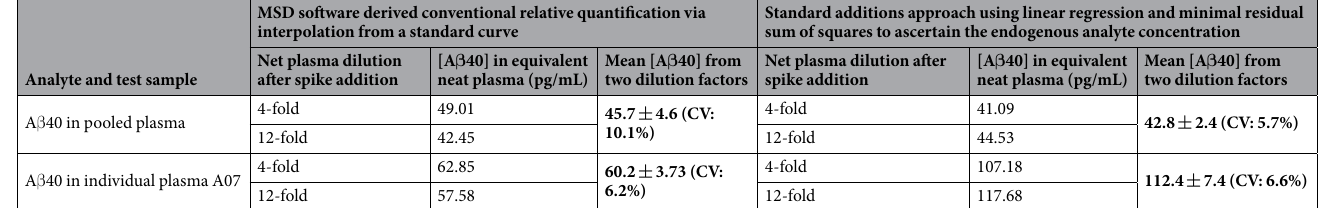
Table 3. Comparison of endogenous A β 40 concentration data derived by conventional relative quantification of the unspiked test samples and the standard addition approach using linear regression to correlate the signal output with the total analyte concentration of spiked test samples. A summary of endogenous A β 40 concentrations within the pooled female human plasma and the individual female human plasma sample termed A07, determined using conventional relative quantification from a 4-PL fit curve and the novel method of linear regression based on minimising the residual sum of squares to assess concordance when the dilution factor is